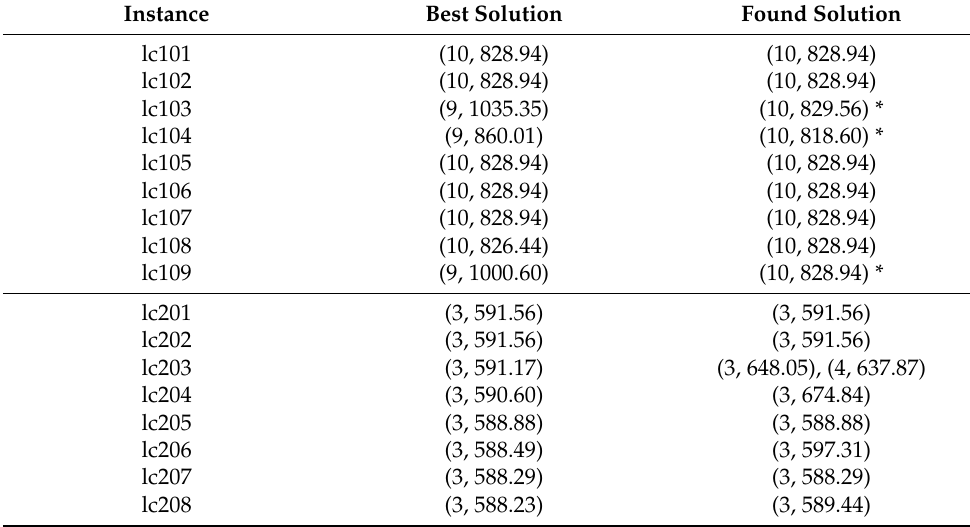
Table A1. Results on Li-Lim’s